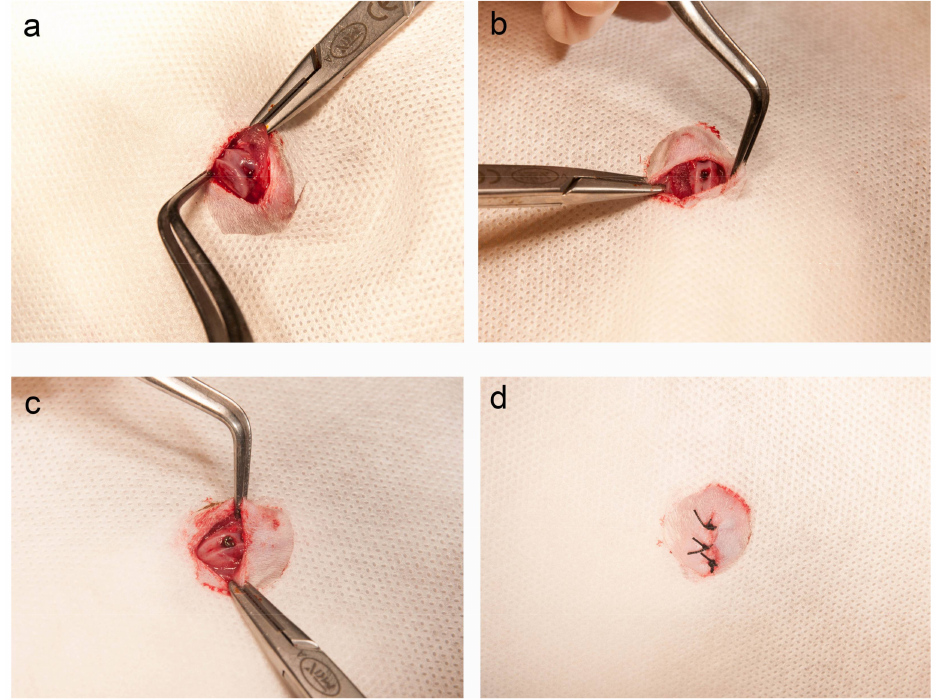
Figure 7. Implantation into rat femurs. ( a ) Incision; ( b ) Drilling of a hole; ( c ) Placement of implant; ( d )